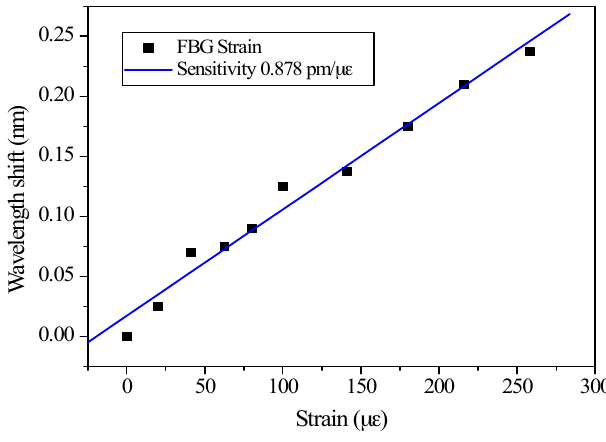
Figure 5. The fiber strain sensitivity from the FBG Bragg wavelength shifts.